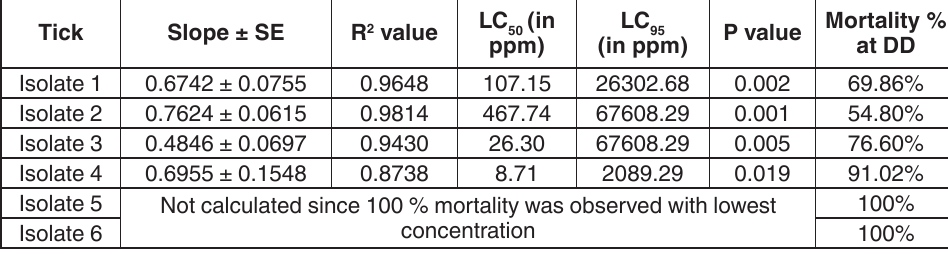
concentration Isolate 6 Mortality % lc lc 50 95 P value at DD (in ppm) (in ppm)